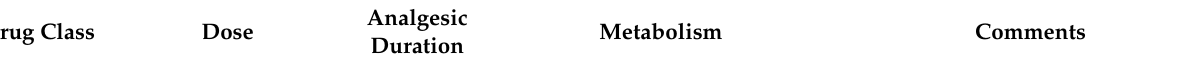
Table 5. TRPV1 receptor agonist